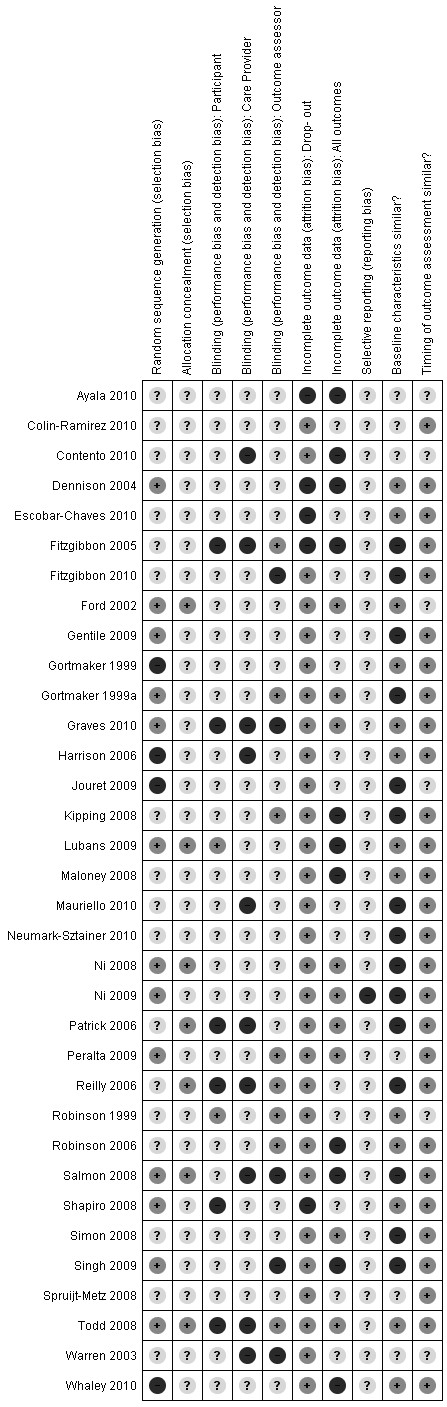
Risk of bias summary.